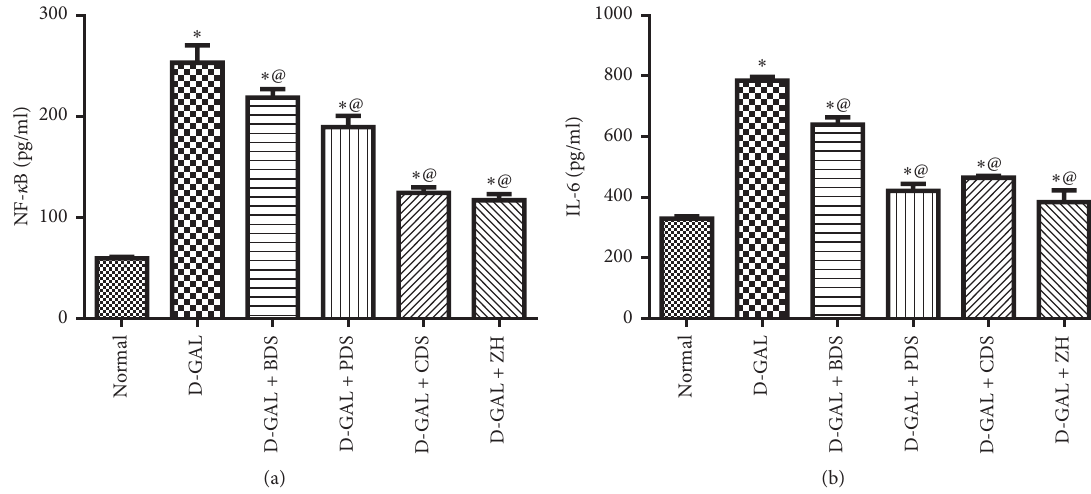
Figure 3: Effect of D. salina on hepatic NF- Κ B (a) and Il-6 (b) levels in albino rats with age-related hepatic steatosis. Age-related hepatic steatosis was induced in rats by injections of D-galactose (200mg/kg I.P) for eight weeks. Rats injected with oral D-galactose for two weeks were treated with BDS (450mg/kg), PDS (30mg/kg), CDS (30mg/kg), or ZH (250 μ g/kg). Twenty-four hours later, the last dose of the treatment, rats were sacrificed and liver tissues were homogenized. Tissue homogenate was used for IL-6 and NF- Κ B measurements. Data are expressed as mean ± SEM from the normal value. Statistical analysis was performed by one-way analysis of variance (ANOVA) followed by Tukey–Kramer test for multiple comparisons. ∗ Significantly different from the normal control group at P ≥ 0 . 05. @ Significantly different from D-galactose control at P ≥ 0 .